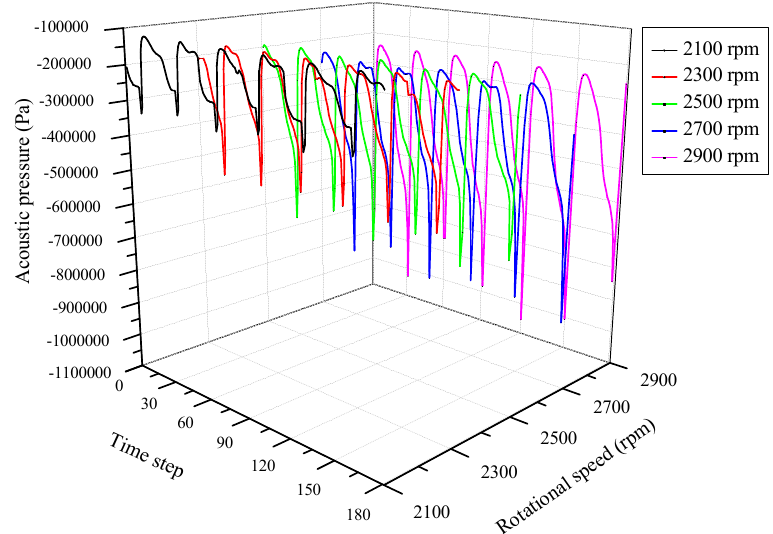
Figure 14. The fluctuation characteristics of acoustic pressure under various rotational speeds.